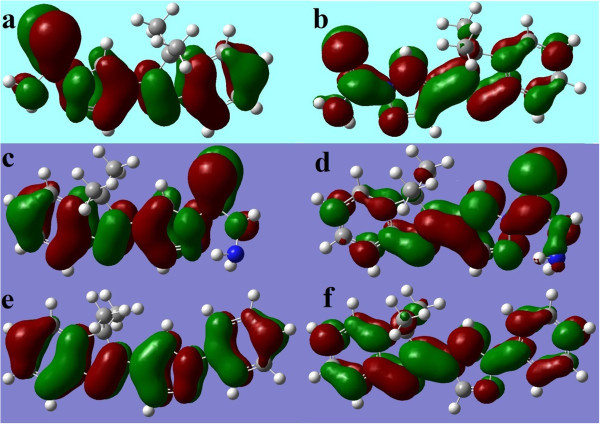
Frontier molecular orbital density distribution for InPzTAm (a; HOMO, b; LUMO), InPzTH (c; HOMO, d; LUMO) and InPzPh (e; HOMO, f; LUMO).